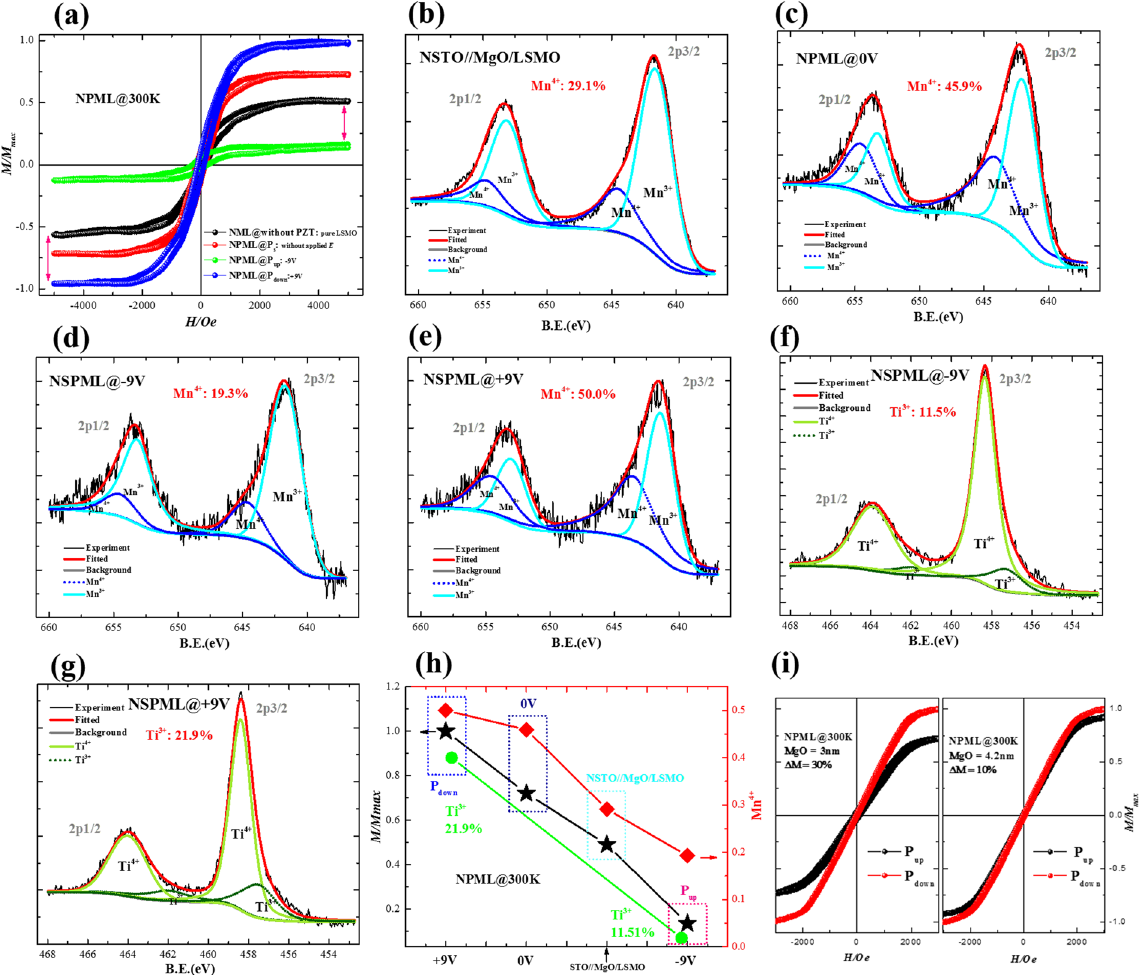
Figure 4. ( a ) M-H curves under various voltages, ( b – g ) XPS curves of Mn and Ti ions, ( h ) the dependence of Ms, the ratio of Mn 4 + and Ti 3 + on voltages, ( i ) M-H curves under various voltages with different thickness of MgO, for the NPML